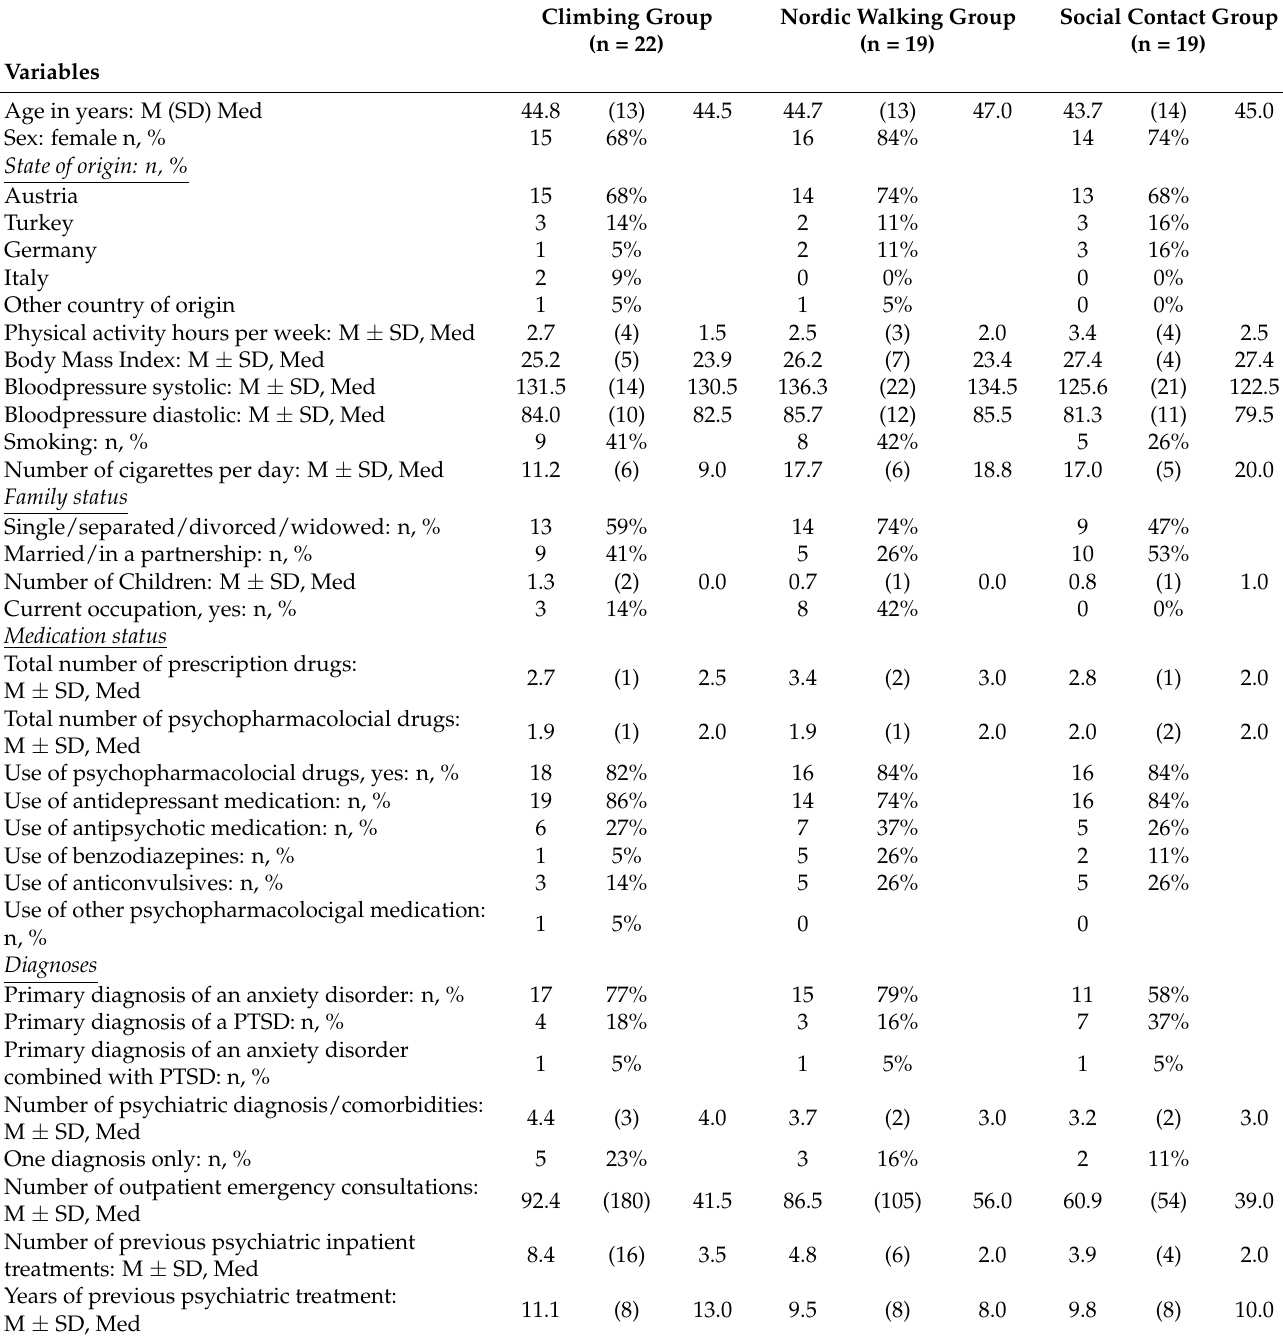
Table 1. Sociodemographic, clinical, and health-related characteristics. Climbing